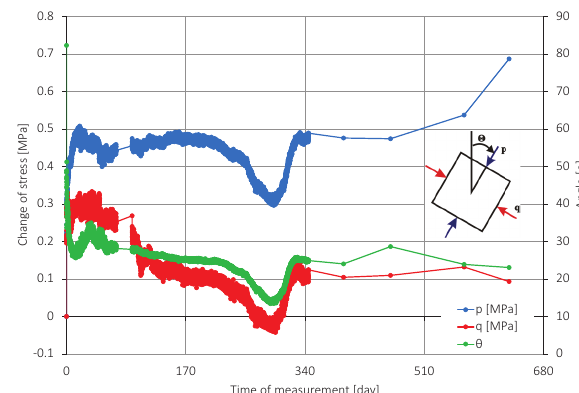
Fig. 8. Change of values and orientation of principal stresses in Eastern guideline Figure 8: Change of values and orientation of principal stresses in Eastern